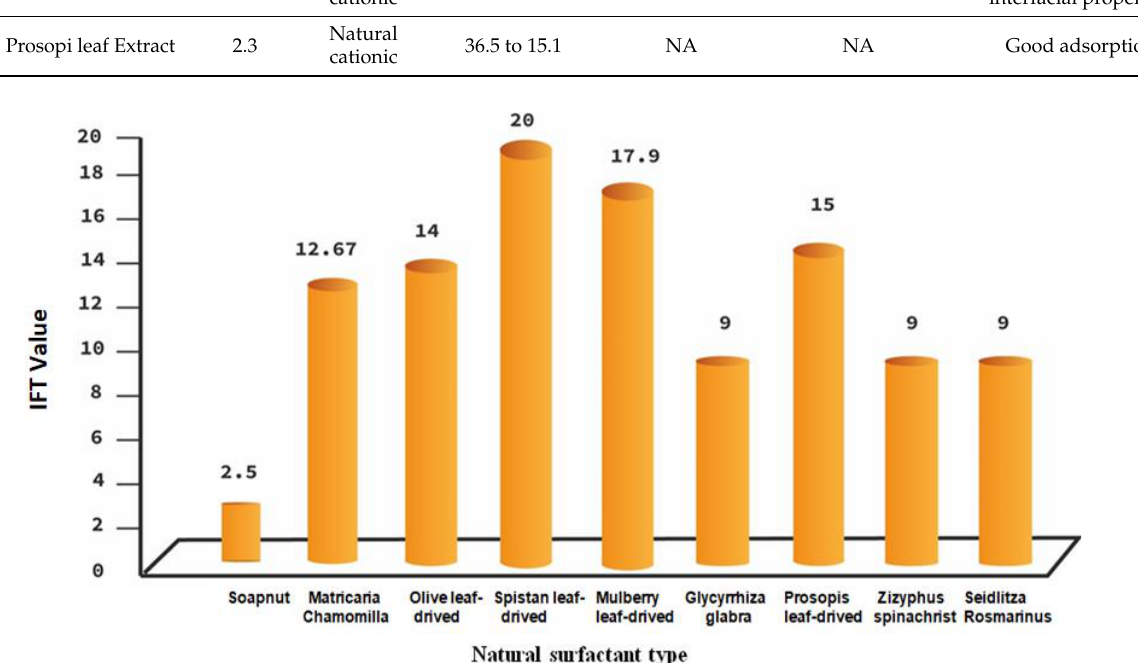
Figure 2. Summary of experimental data for different kinds of natural surfactant. Table 2. Summary of natural surfactant types and their properties.